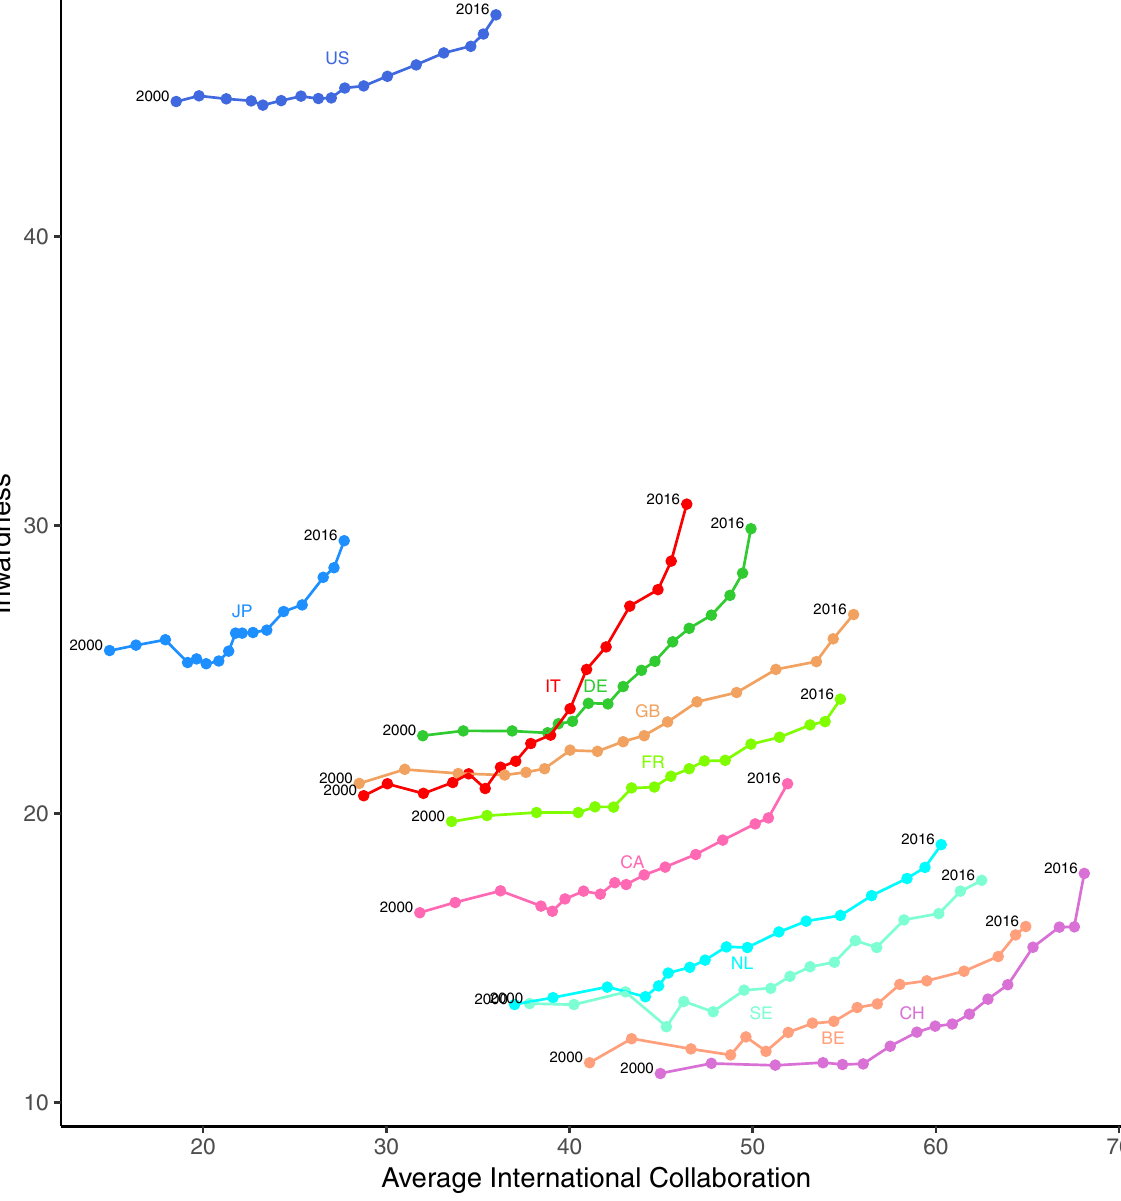
Fig 2. Inwardness versus average international collaboration for the G10 countries. The average international collaboration is the 3-year moving average calculated starting from the considered year. The international collaboration is defined as the share of publications of a country coauthored by at least a coauthor of a different country. Source: elaboration from SCIval data.